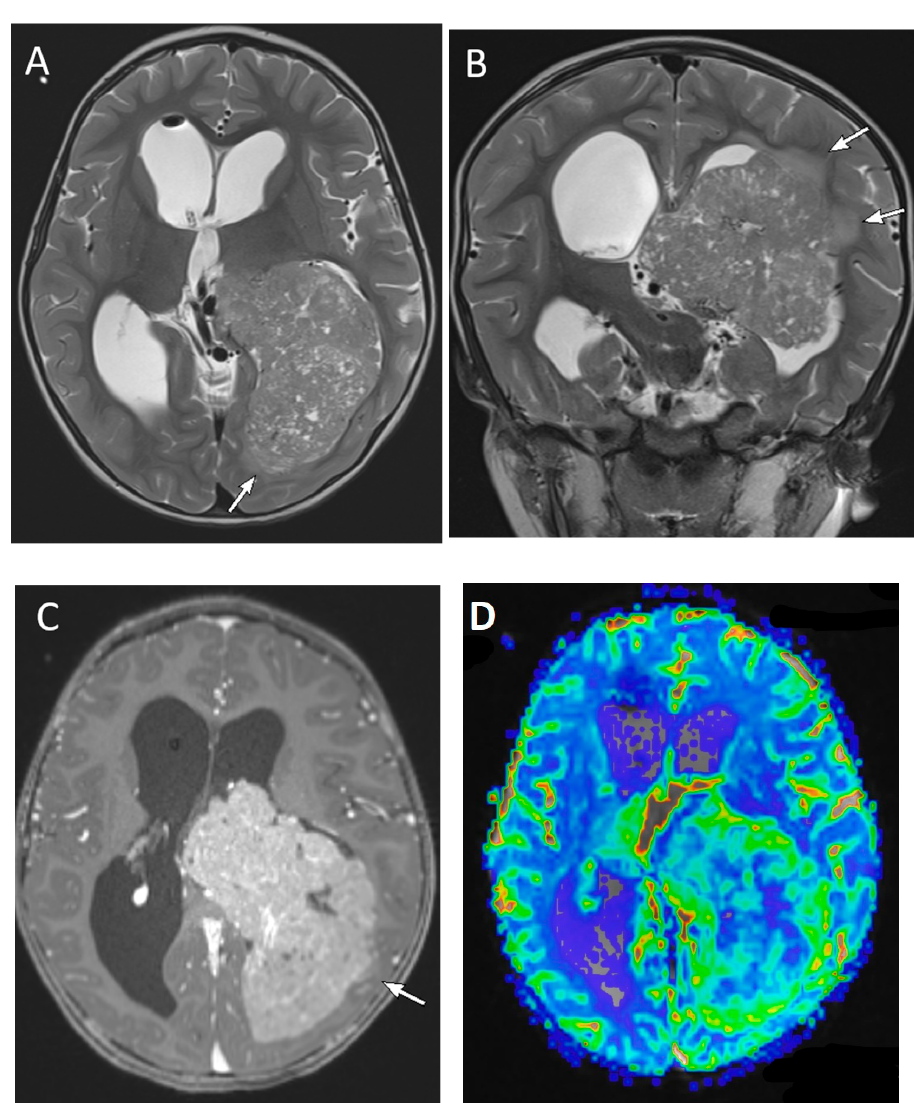
Figure 11. A 2-year-old male with choroid plexus carcinoma. Axial and coronal T2-weighted ( A , B ), axial post-contrast T1-weighted ( C ) and axial perfusion rCBF ( D ) images demonstrate a large, predominantly solid mass with scattered tiny cystic foci, within the atrium and occipital horn of the left lateral ventricle. There is diffuse enhancement of the tumor and increased blood flow on the perfusion maps. The presence of parenchymal invasion (arrows on ( A – C )) distinguishes choroid plexus carcinoma from papilloma.